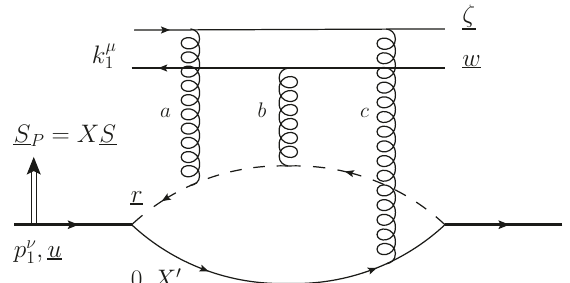
Figure 7. Diagram for the odderon exchange amplitude with the quark-diquark model of the proton, where all possible connections of the three gluons to the quark (solid line at the very bottom) and diquark (dashed line) and to the ζ, w dipole at the top should be summed over and the gluons are in the symmetric d abc color